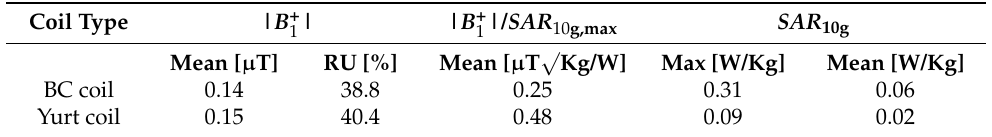
Table 1. The summary of the statistics from the normalized B 1 field and specific absorption rate (SAR) from each coil in the whole head